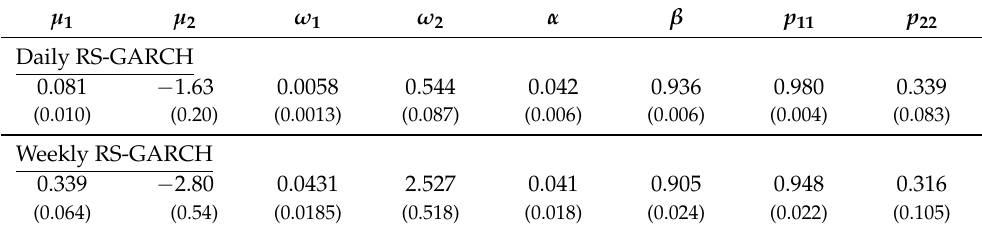
Table 1. Parameter estimates for the daily and weekly RS-GARCH